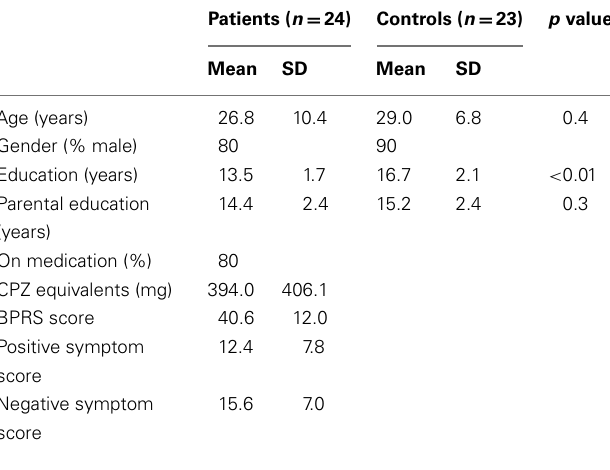
Table 1 | Subject demographic and patient clinical